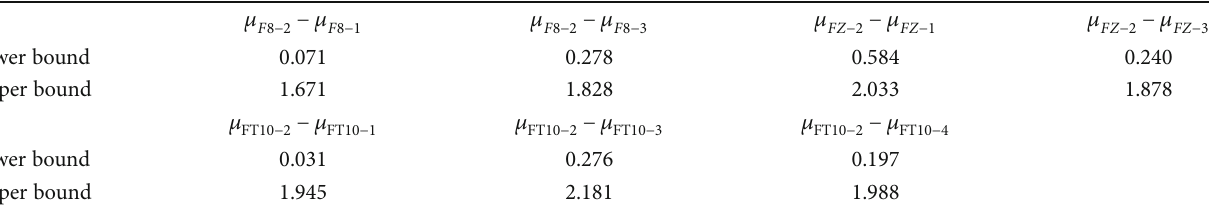
Table 11: Con fi dence interval data of mean in